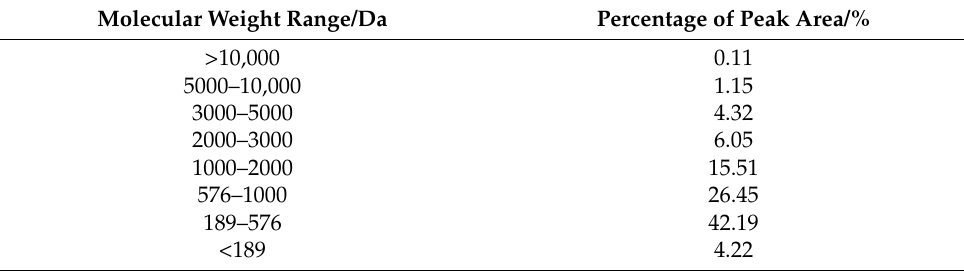
Table 2. The molecular weight distribution of the